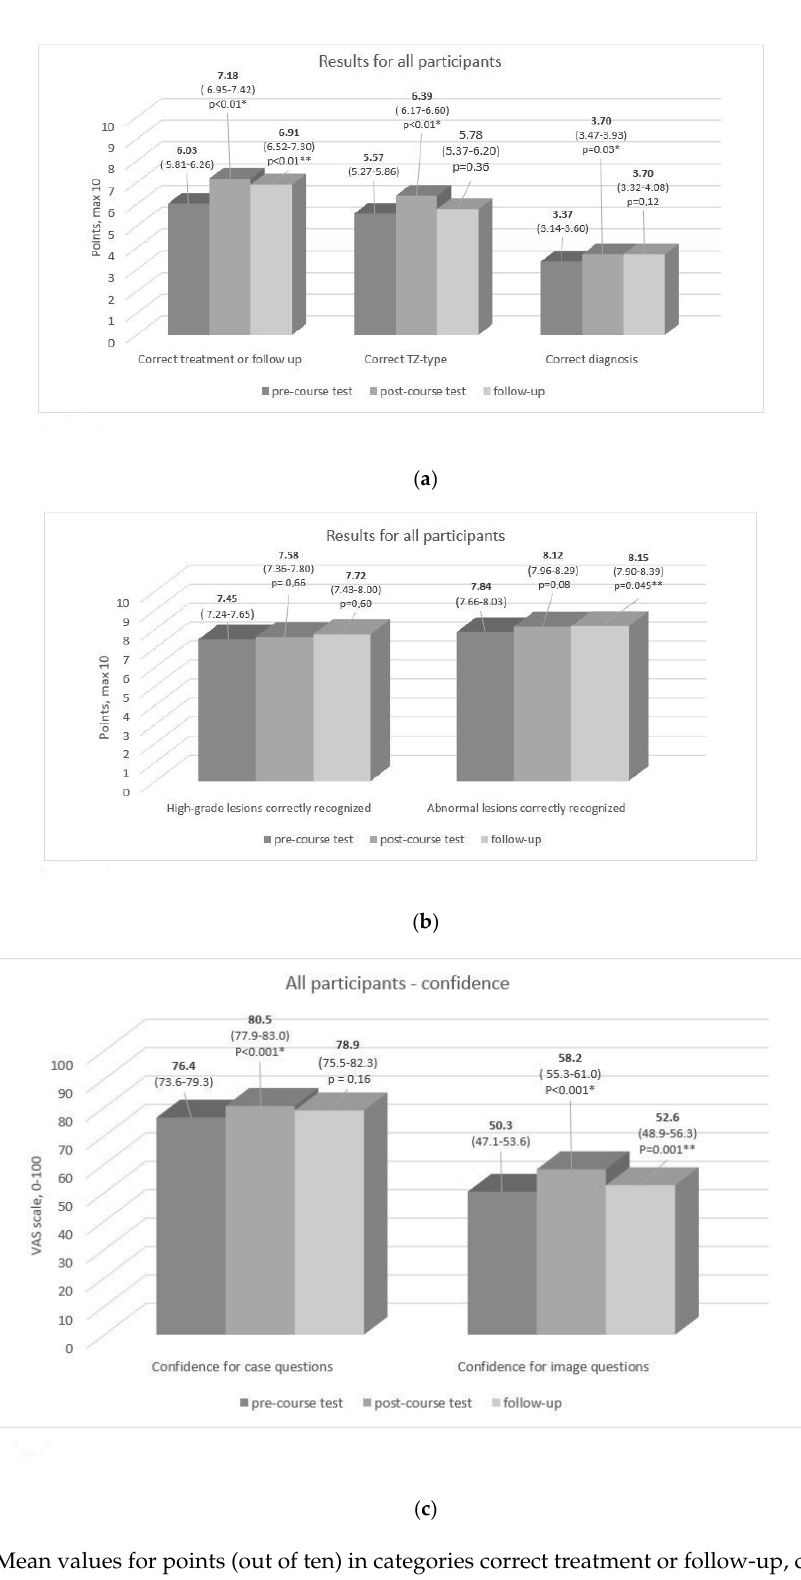
Figure 2. Mean values for points (out of ten) in categories correct treatment or follow-up, correct TZ and correct diagnosis ( a ), categories high-grade lesion recognized and abnormal lesion recognized ( b ), and values for confidence (0 = not at all confident, 100 = very confident) ( c ) for all participants. p-Value is presented if the change in points or confidence pre- to post-course test (marked with *), and pre-course to follow up (marked with**) is statistically significant. Numbers in parentheses indicate 95% confidence